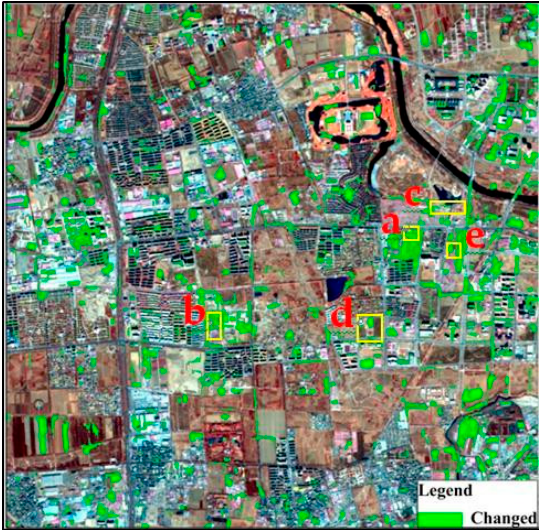
Figure 17. ODCD land cover change detection result overlaid on the GF-1 image of Beijing in February 2017.